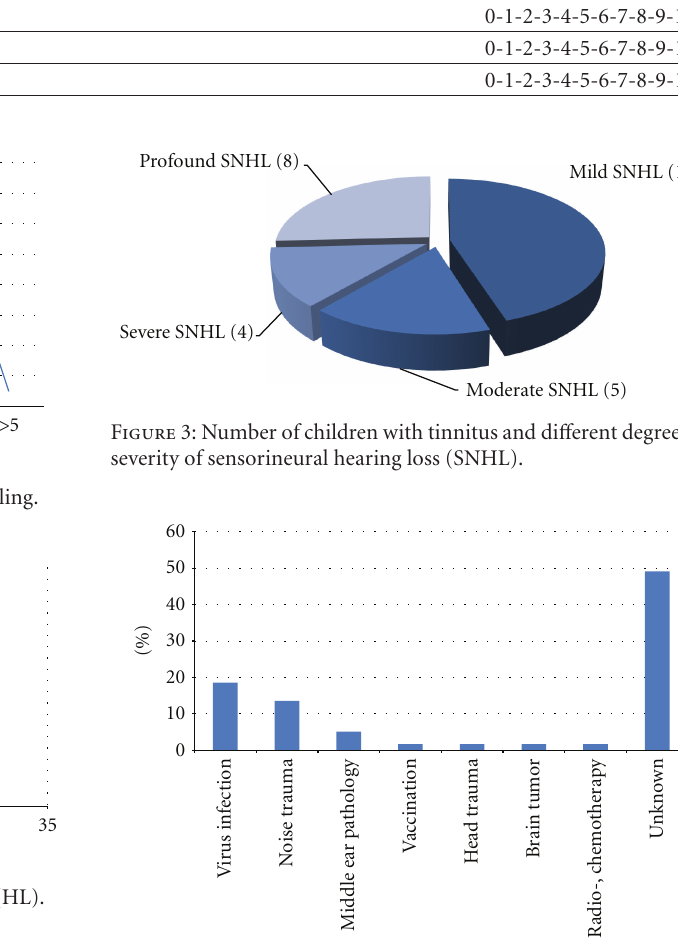
Figure 4: The suspected etiology of tinnitus in the study